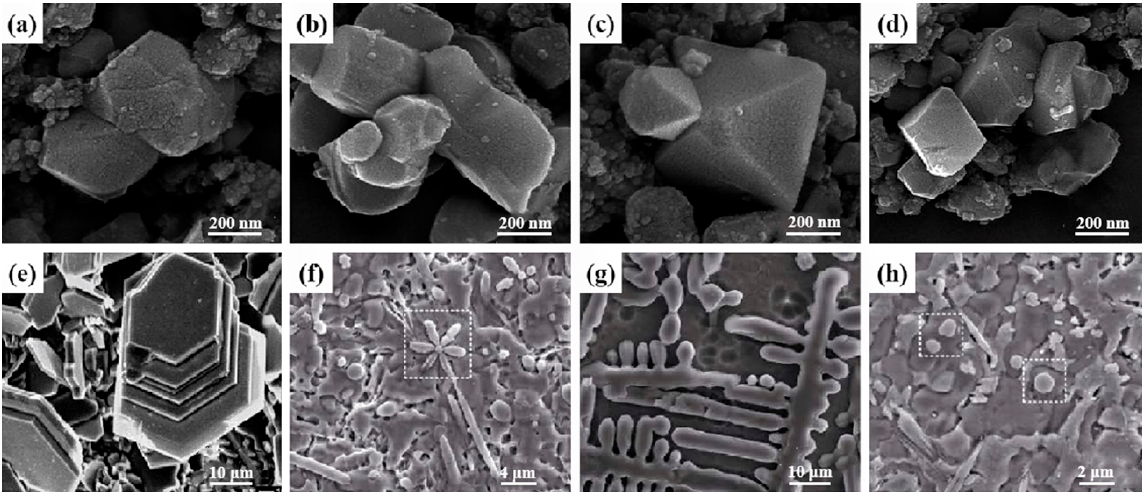
Figure 3. Typical morphologies of TiCx: ( a ) polyhedron shape, ( b ) cuboctahedron shape, ( c ) octahedron shape, ( d ) truncated octahedron shape, ( e ) hexagonal shape, ( f ) petaloid shape, ( g ) dendritic shape, ( h ) spherical shape.